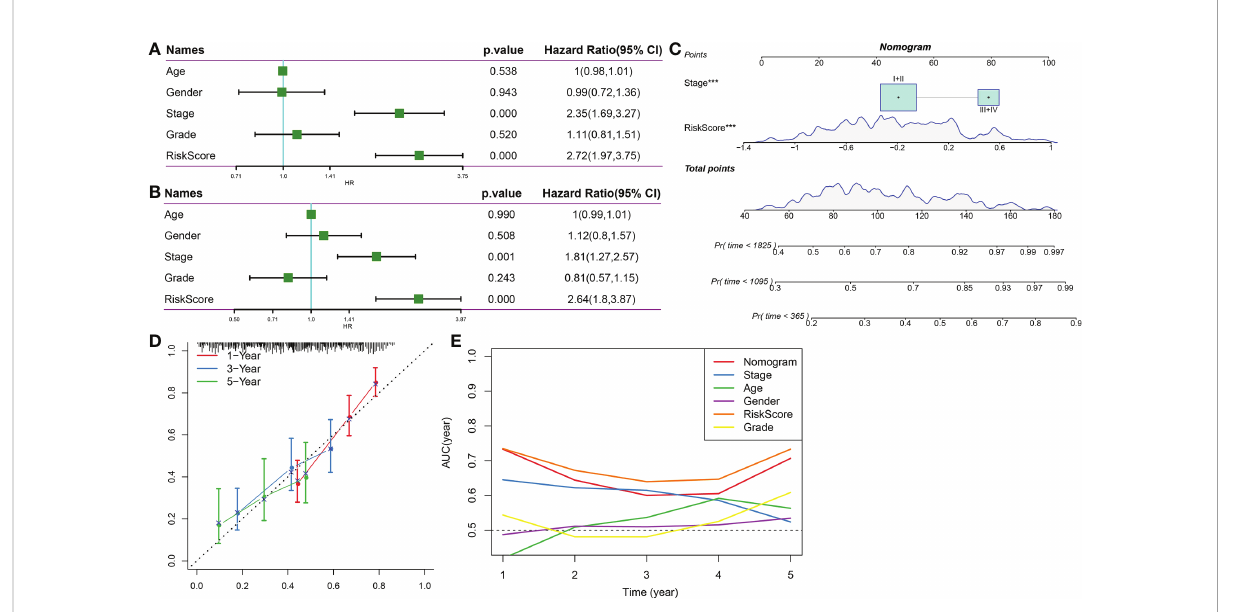
FIGURE 12 Nomogram. (A) Univariate Cox survival analysis. (B) Multivariate Cox survival analysis. (C) Construction of nomogram based on Stage and RiskScore. (D) The calibration curve proved that the prognostic nomogram was reliable and accurate. (E) AUC analysis of nomogram, RiskScore, age, stage, gender, and grade.